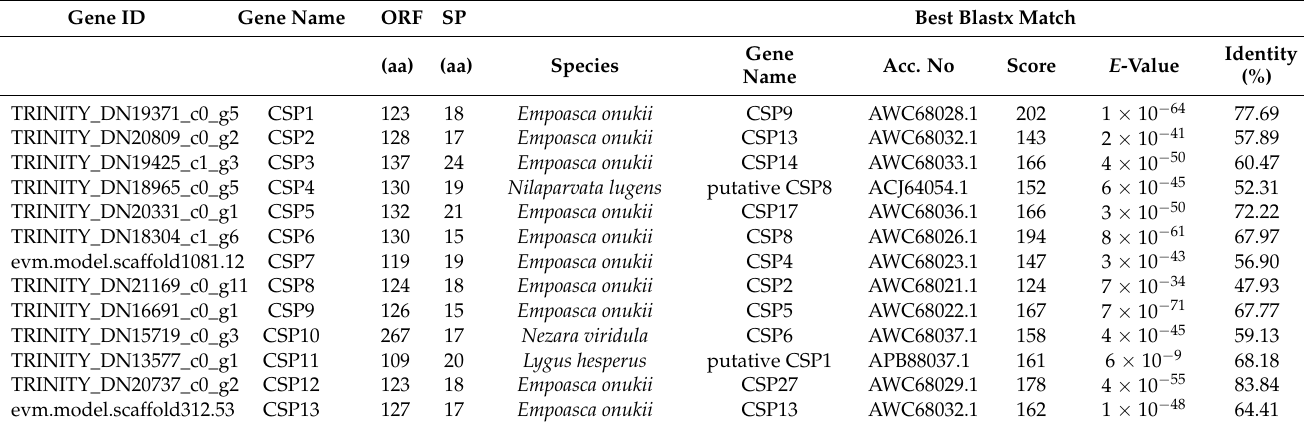
Table 2. List of identified CSP genes of N. cincticeps